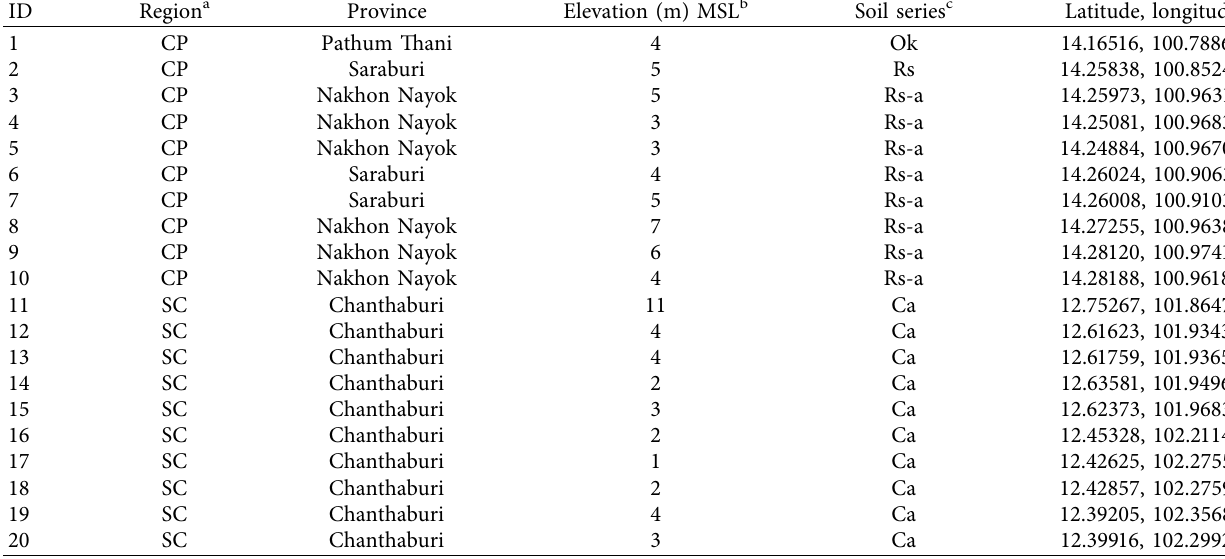
Table 1: Site descriptions of acid sulfate soils under oil palm planting areas in Central Plain and Southeast